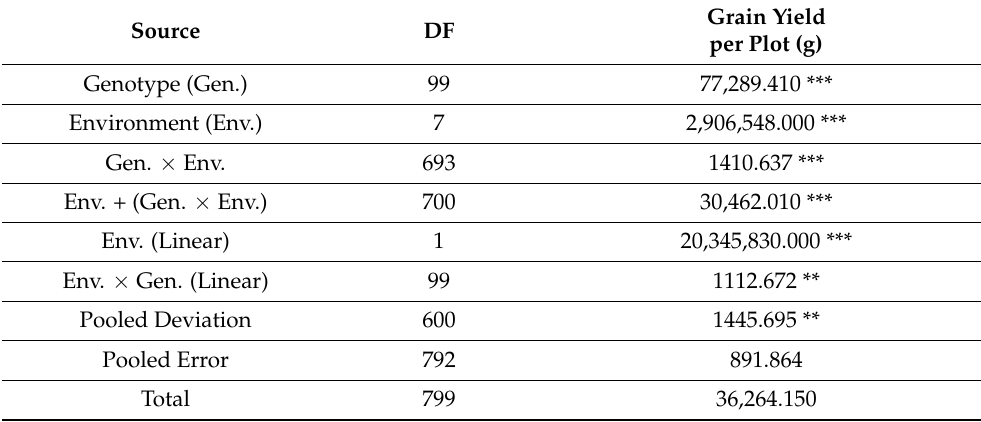
Table 6. Pooled analysis of variance of 100 genotypes across eight environmental conditions for grain yield per plot in wheat (Eberhart and Russell, 1966